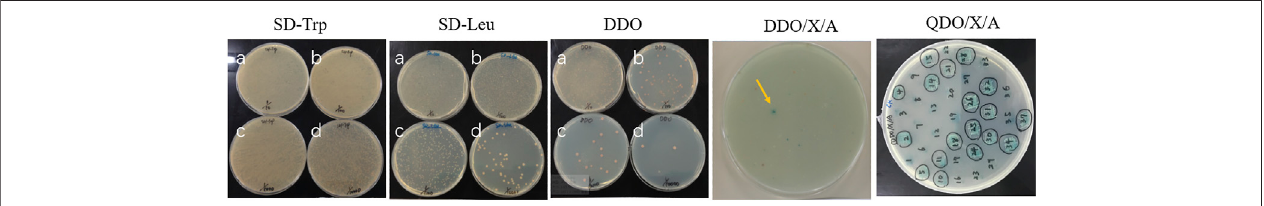
FIGURE2| Cry1Ab/c-interactingendogenousproteins.Thegrowthofco-transformedY2HGoldyeastcoloniesharboringCry1Ab/c-BDandcDNA-ADatnutrient- de fi cient SD/-Trp, SD-Leu, DDO, DDO/X/A and QDO/X/A, respectively. (a – d) The dilution ratio is 1/10, 1/100, 1/1000, 1/10,000, respectively. (BD) PGBKT7, (AD) PGADT7. Yellow arrow and black circle indicate positive clones.